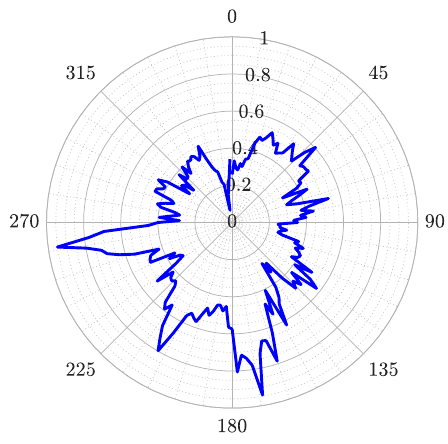
Figure 8. Wind power fluctuation enhancement of the whole wind farm for certain wind directions. The radial axis is the ratio of fluctuations between the whole wind farm and a free-flow reference wind